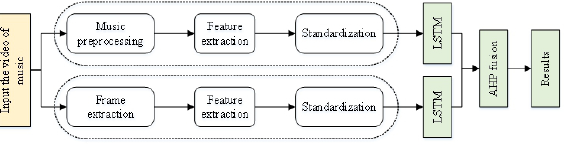
Fig. 1. The architecture of multi-modal music emotion analysis